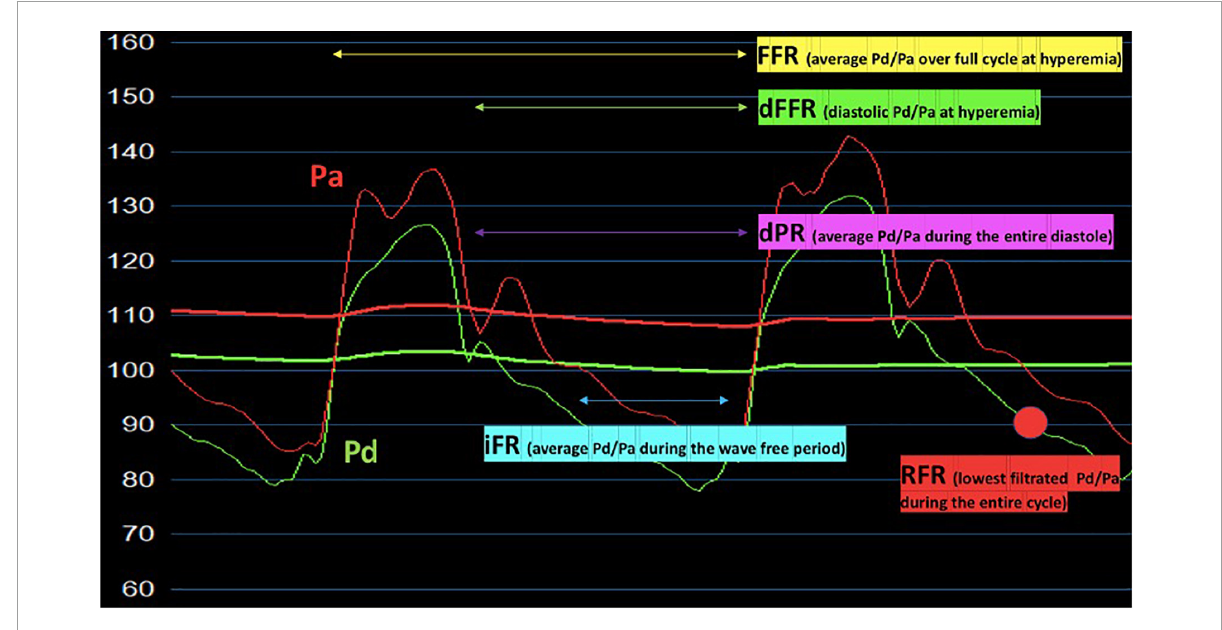
FIGURE2 Hyperemic and non-hyperemic pressure ratios (FFR, dFFR, iFR, RFR, dPR) proposed for the invasive functional assessment of patients with myocardial bridging. Pa, aortic pressure; Pd, distal pressure; FFR, fractional flow reserve; dFFR, diastolic-fractional flow reserve; iFR, instantaneous wave-free pressure ratio; RFR, resting full-cycle ratio dPR, diastolic pressure ratio.